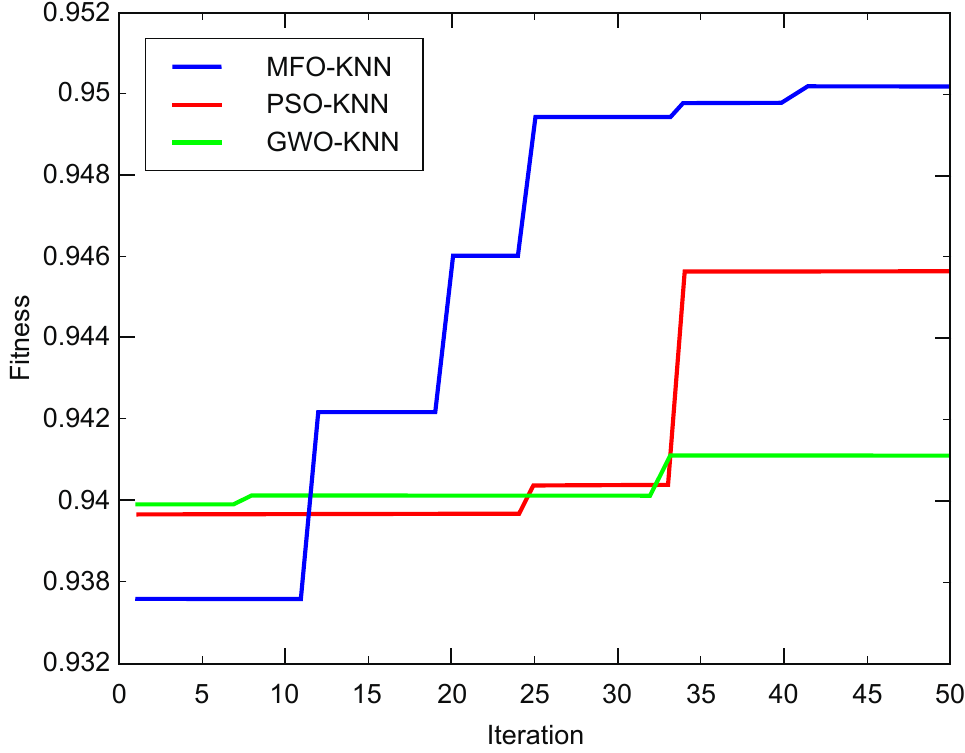
Figure 4. Fitness curve of 4000 data sets.